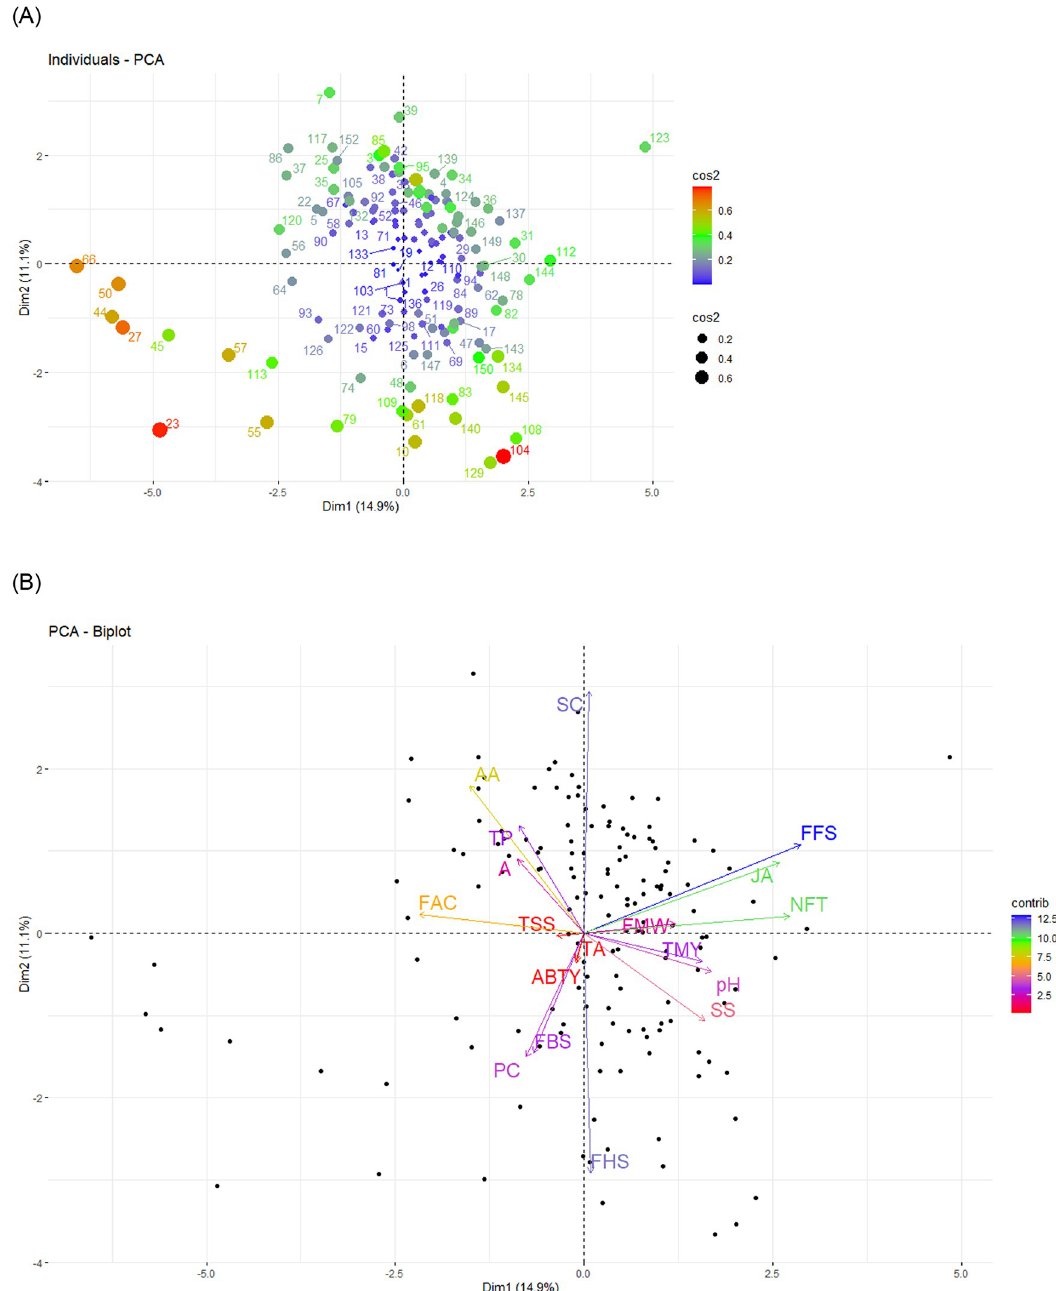
Fig 5. Biplot of the first two principal components (PCs) for the studied pomegranate genotypes (A) and targeted metabolites and morphological traits (B).